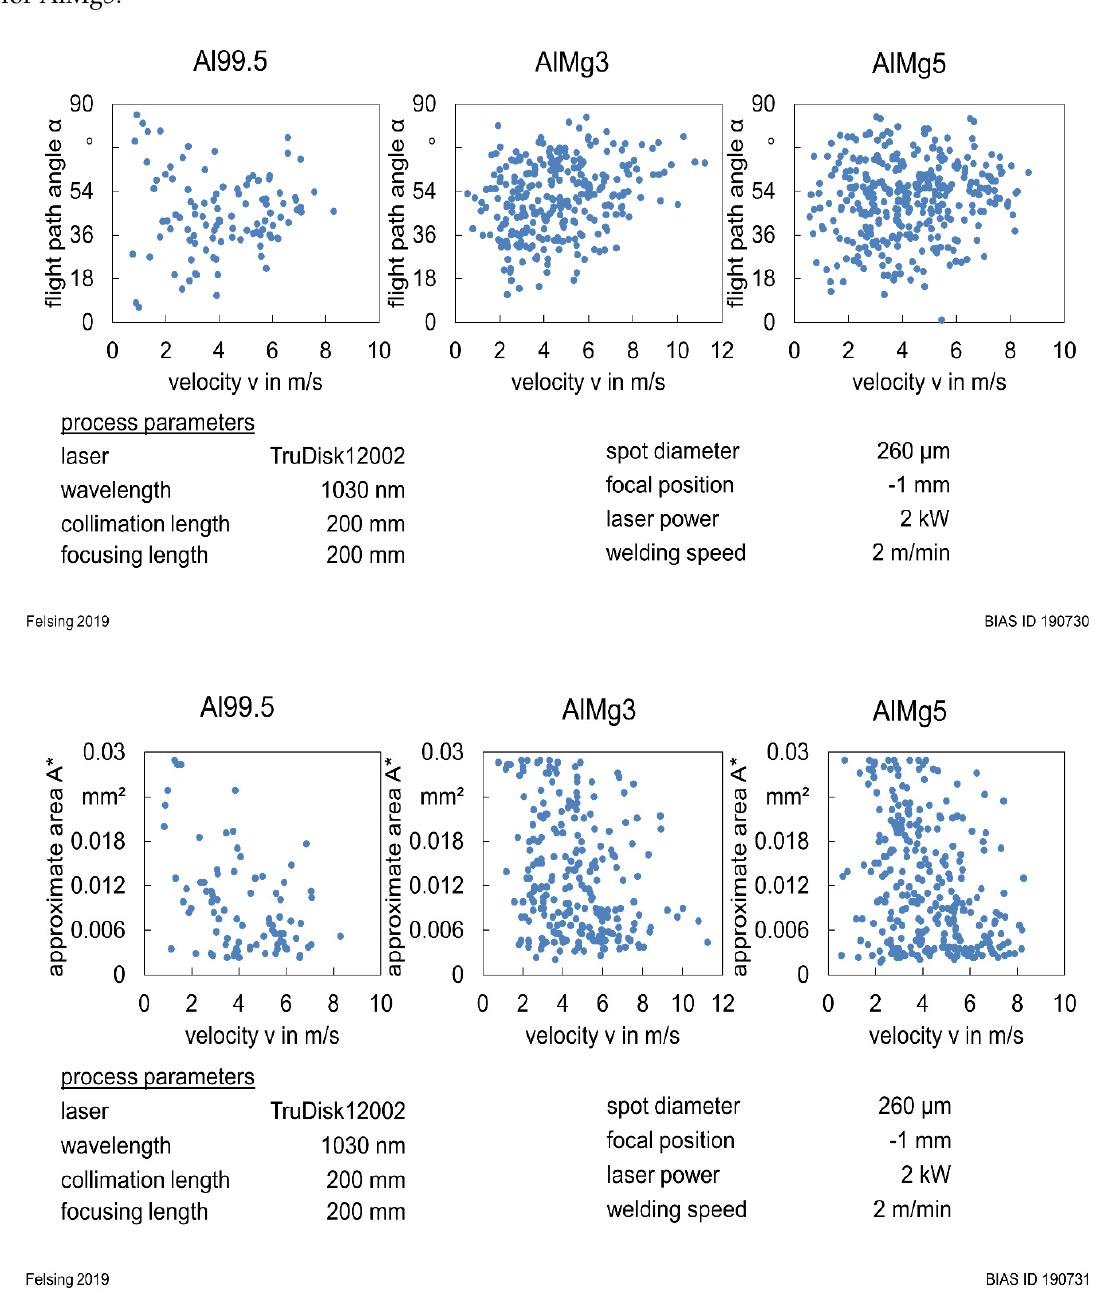
Figure 10. Scatter plots of spatter flight path angles and approximated spatter areas dependent on spatter velocities (analysis for quadrants I and IV for Al99.5, AlMg3, and